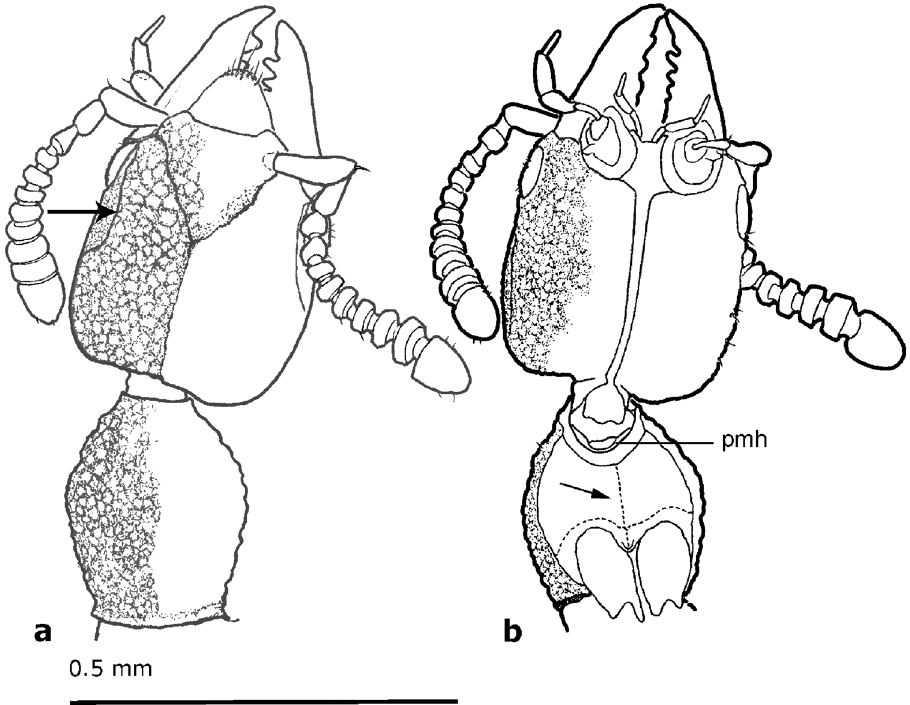
Figure 3. Schematic drawings of Midinudon juvenis gen. and sp. nov. based on holotype, collection number GPIH05515 specimen. Head and prothorax. (a) Dorsal view; ridge separating the flat area above and behind the eye marked with an arrow. (b) Ventral view; longitudinal ridge of basisternum marked with an arrow. Pmh – posterior margin of